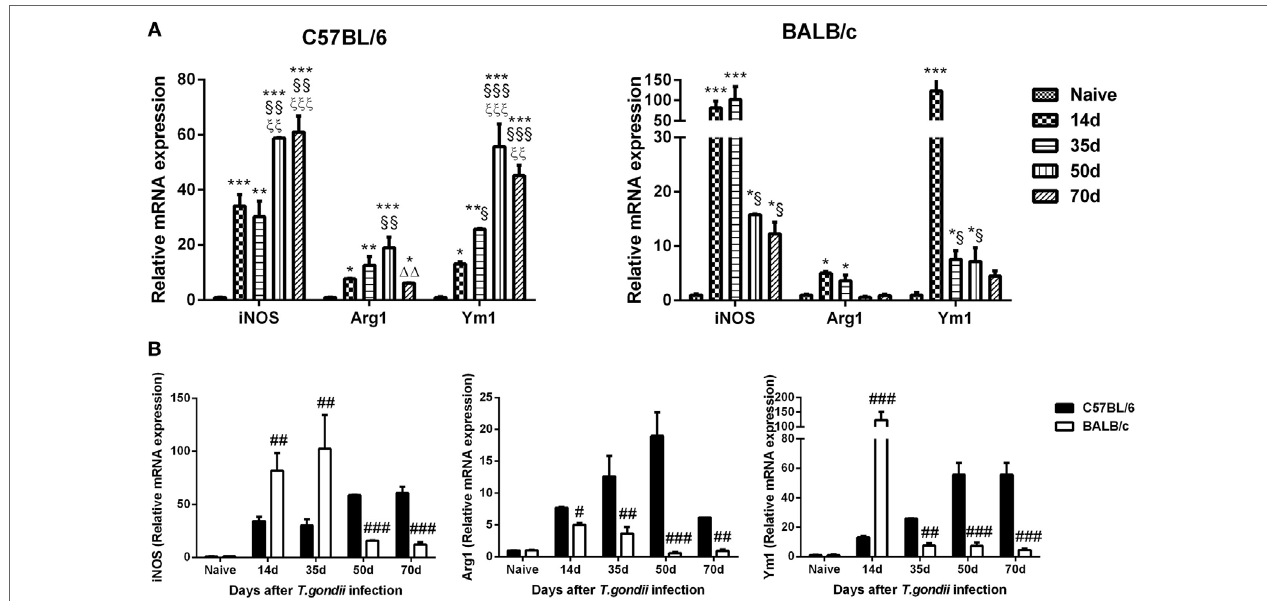
FigUre 3 | Relative mRNA expressions of inducible nitric oxide synthase (iNOS), arginase1 (Arg1), and Ym1 in the brain tissues of Toxoplasma gondii Pru strain-infected C57BL/6 and BALB/c mice were detected by using quantitative real-time reverse transcription-polymerase chain reaction. (a) iNOS, Arg1, and Ym1 expressions in the brains of C57BL/6 and BALB/c mice. (B) Comparison of iNOS, Arg1, and Ym1 levels in the brains of C57BL/6 and BALB/c mice. Values are means from triplicate measurements, and data are presented as mean ± SD. There were four mice per group. The data shown are representative of those from two different experiments. * P < 0.05, ** P < 0.01, and *** P < 0.001 vs naive; § P < 0.05; §§ P < 0.01, and §§§ P < 0.001 vs 14 days post infection (p.i.); ξξ P < 0.01 and ξξξ